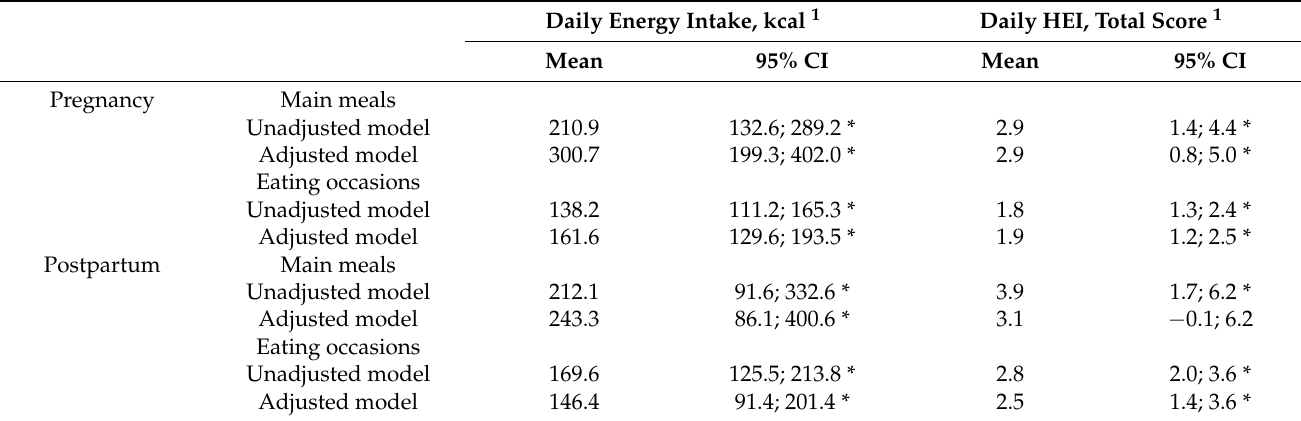
Table 2. Associations of eating frequency with daily energy intake and